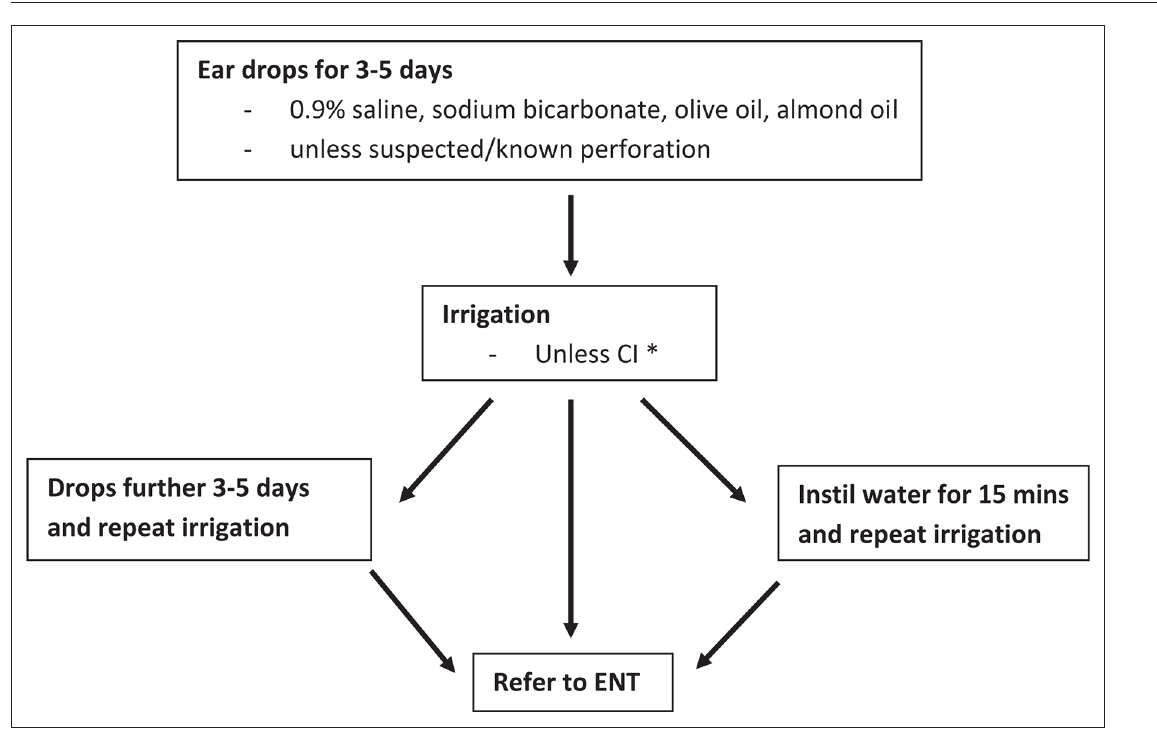
Figure 1 NICE Clinical Knowledge Summaries guidelines on management of earwax.1,5 CI = contraindicated. ENT = ear, nose, and throat services. *Previous ear surgery, anatomical abnormality of canal, history of drum perforation/grommet, only hearing ear, infection, under 16 years, previous intolerance of irrigation. Please refer to the full guidelines for comprehensive information on contraindications to